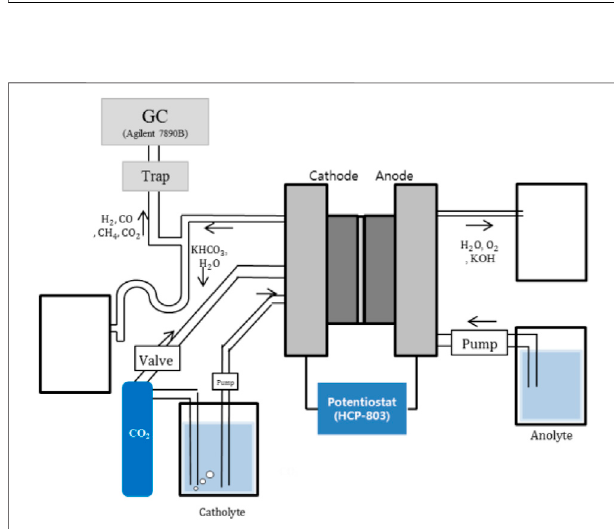
FIGURE 2 | Schematic representation of a carbon dioxide reducing system with a proton exchange membrane.